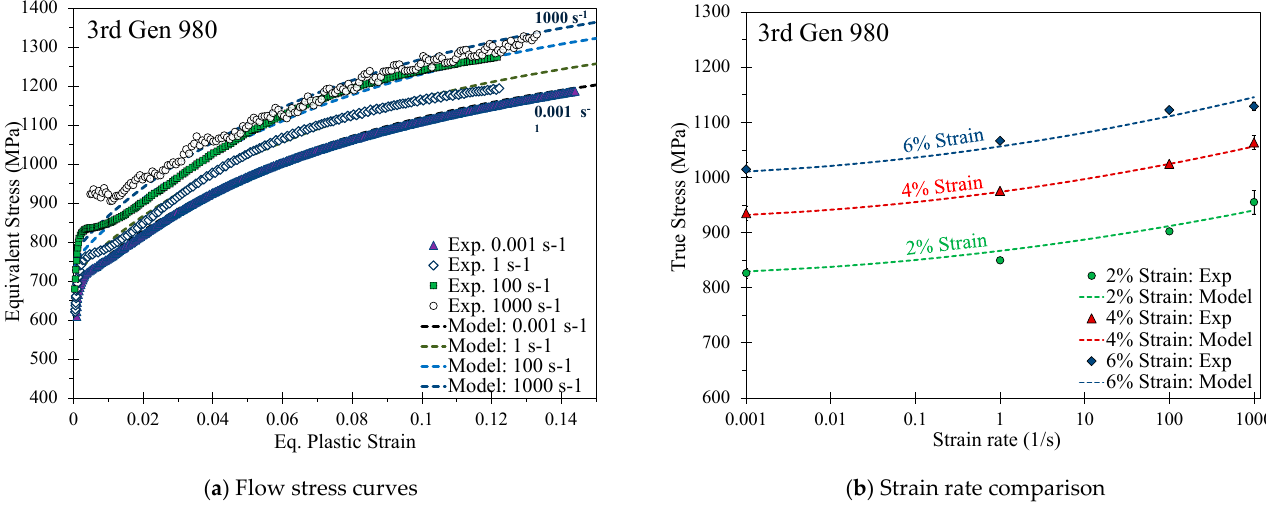
Figure 11. Calibrated quadratic Johnson-Cook rate-dependent constitutive model for the 3rd Gen 980.